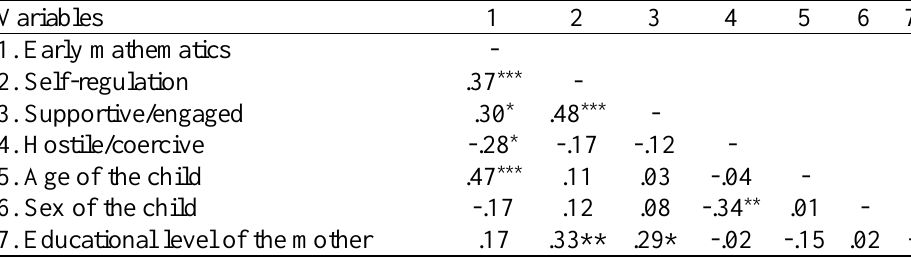
Pearson correlations for the research variables